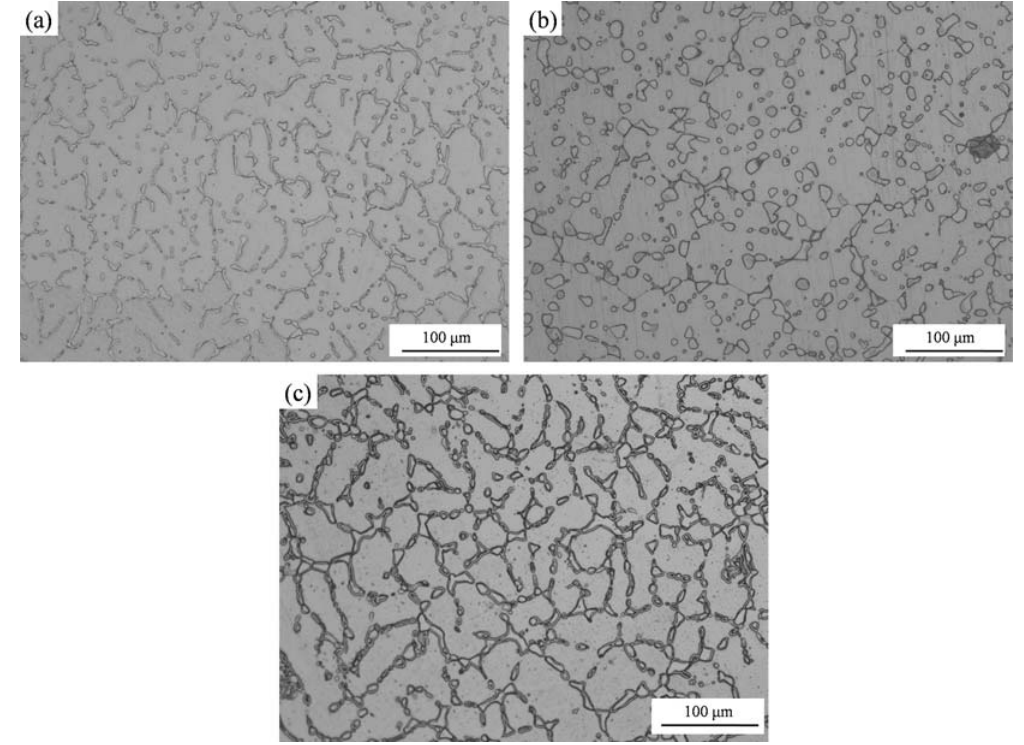
Figure 1. OM ( Optical microscopy ) micrographs of the three NiTi ‐ based SMAs: ( a ) Ni 45 Ti 51.8 Fe 3.2 ; ( b ) Ni 44 Ti 51.8 Fe 3.2 Nb 1 ; ( c ) Ni 44 Ti 51.8 Fe 3.2 Ta 1 .